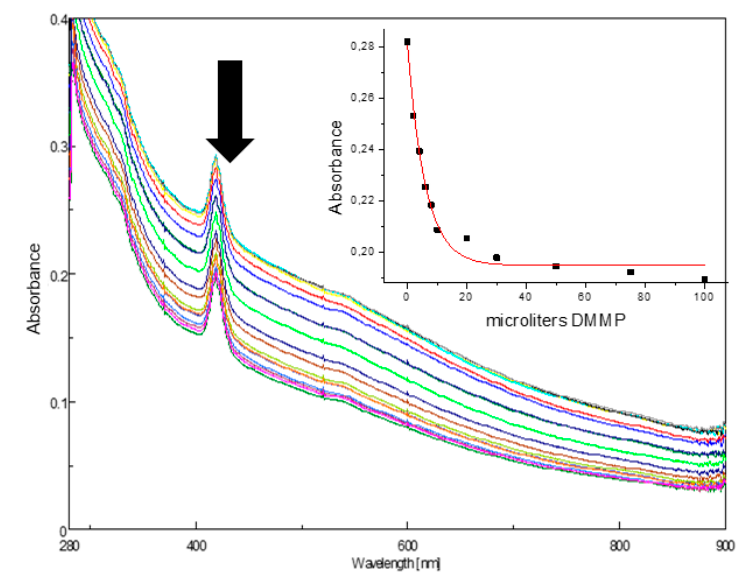
Figure 4. UV-Vis spectra of CNPs-Naphthyl-Di-AE (0.05 mg / mL in toluene) upon progressive addition of DMMP (0–100 µ L of a 1 × 10 − 4 M solution in toluene), inset shows the calibration curve.